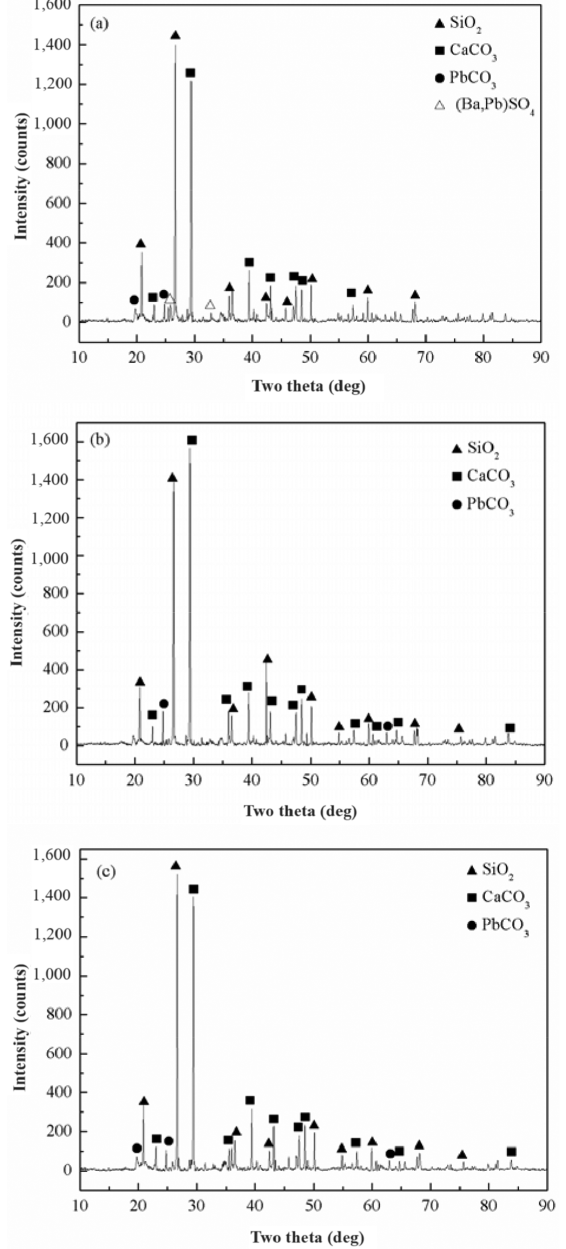
Figure 7: XRD patterns of leaching slags under different sodium citrate contents (a) [Na 3 C 6 H 5 O 7 ] 0 mol/L; (b) [Na 3 C 6 H 5 O 7 ] 0.2 mol/L; (c) [Na 3 C 6 H 5 O 7 ] 0.35 mol/L.